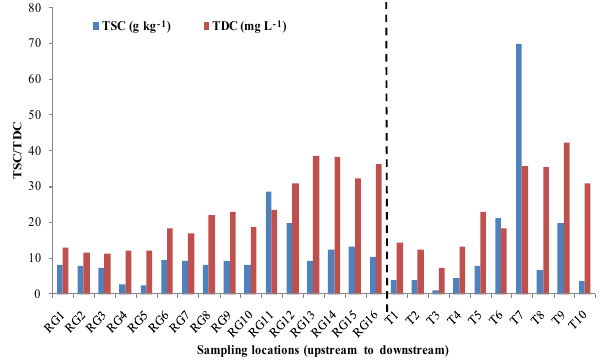
Figure 3. Spatial variation of TSC and TDC in Ramganga River and its tributaries.